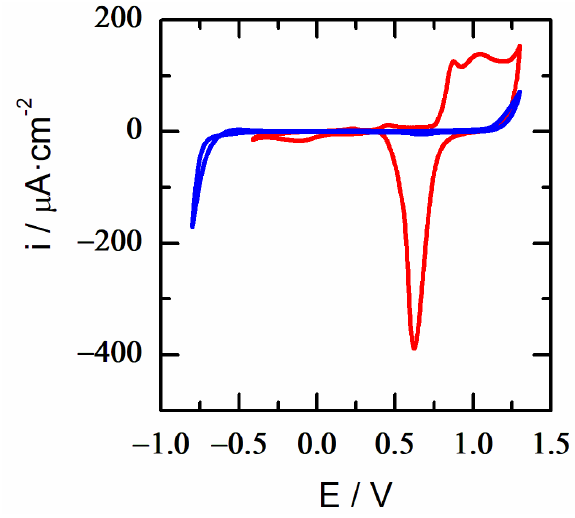
Figure 9. Surface protection. Cyclic voltammetry of Au 18K (red) and DT-SAM Au 18K (blue) in 0.01 M HClO 4 . Scan rate 0.02 V/s.